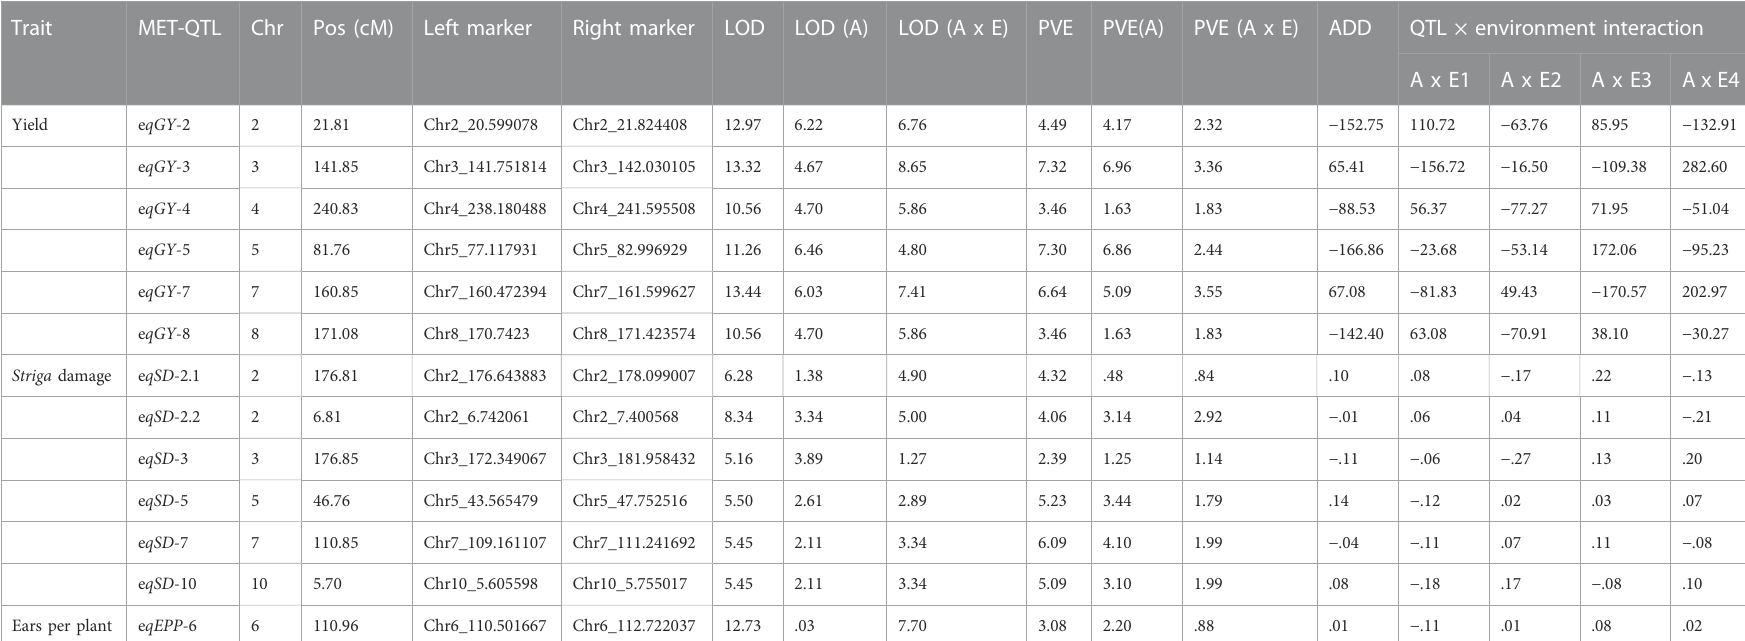
TABLE 5 Characteristics of QTLs related to Striga adaptive traits detected using QEI mapping. Trait MET-QTL Chr Right marker ADD QTL × environment interaction